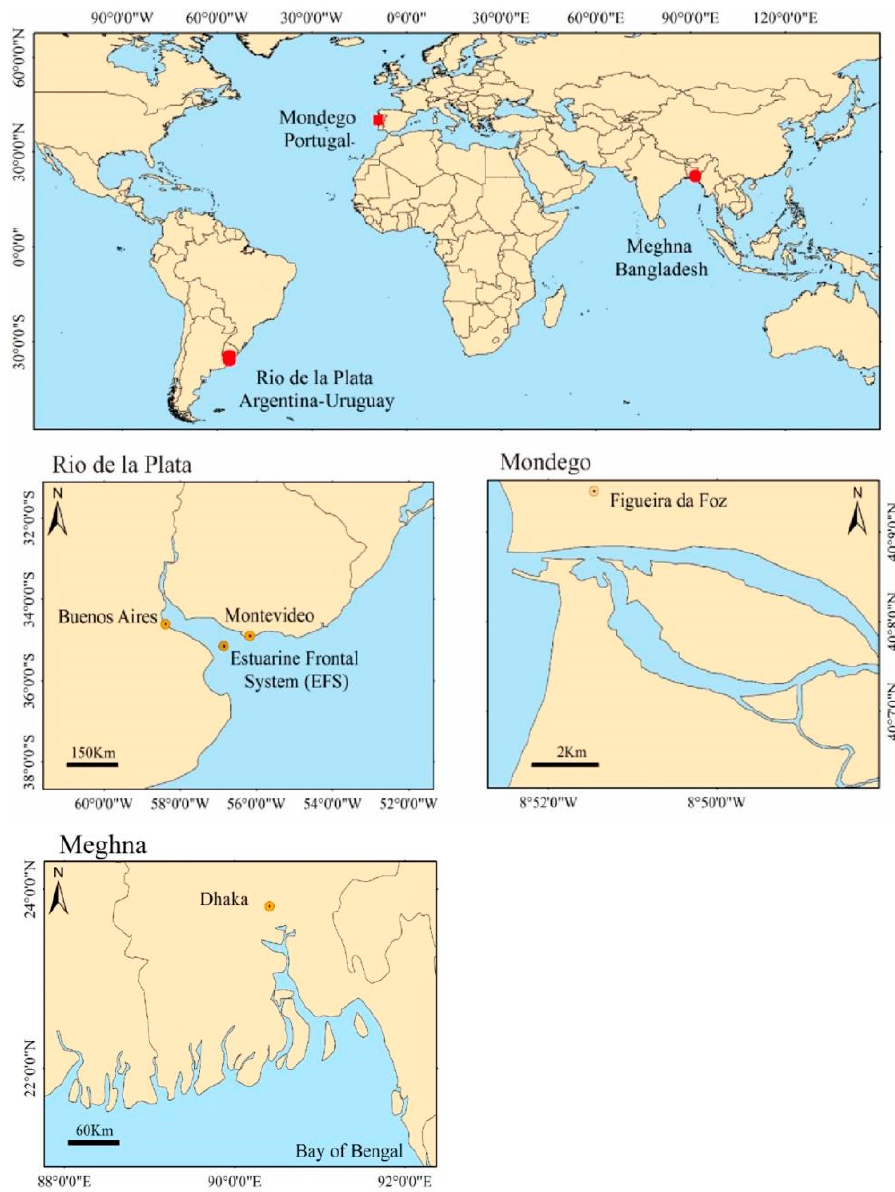
Figure 1. The geographical locations (above) and detailed descriptions of the three estuaries, i.e., Rio de la Plata (RdlP) in Argentina-Uruguay, Mondego in Portugal and Meghna in Bangladesh. The rationales for choosing this set of estuaries are the following. Firstly, they originate from three continents, with various climatic impacts and adaptation strategies. Secondly, they illustrate the magnitude of the riverine influence and drivers of climate variability such as the North Atlantic Oscillation (NAO), the El Niño Southern Oscillation (ENSO) and monsoons, as well as expected climate changes. Thirdly, they provide valuable ecosystem services for sustainable development. Although no broad generalisations are possible, the three studied estuaries offer insights into the nature of various climate threats and impacts on estuaries across the three distinct geographical